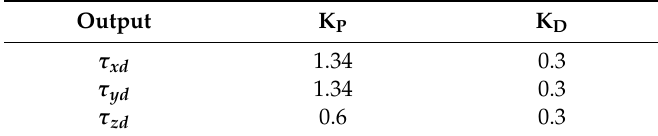
Table 3. Components of the attitude PD controller (K P —the proportional part of the PD controller, K D —the derivative part of the PD controller, τ id —the desired torque of the quadrotor around all axes, i = x , y , z ). Output K P K D τ xd